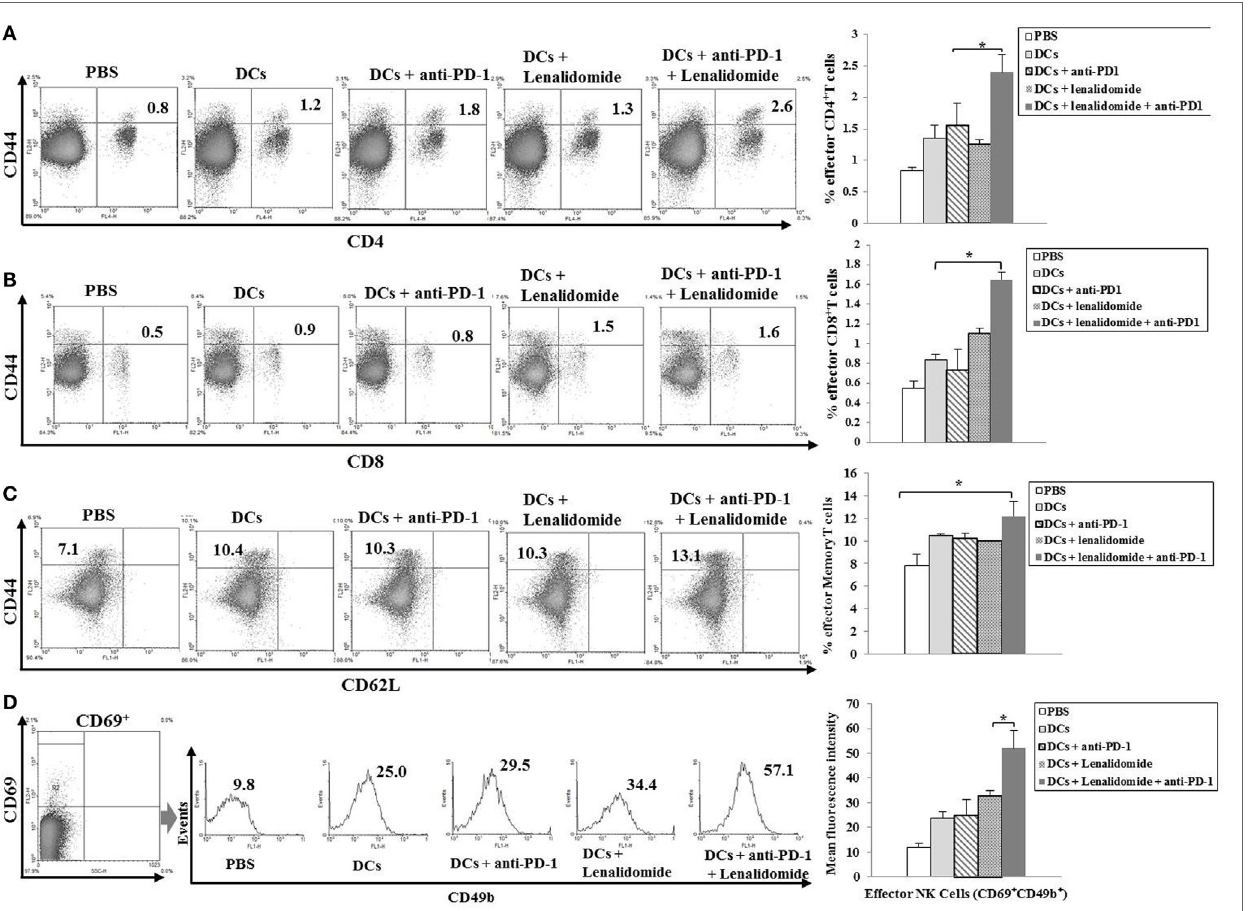
FigUre 3 | Induction of CD4 + T cells, CD8 + T cells, memory T cells, and natural killer (NK) cells in the spleens of mice treated with a combination of dendritic cells (DCs) plus lenalidomide and anti-PD-1. We measured proportions of (a) CD4 + T cells, (B) CD8 + T cells, (c) memory T cells, and (D) NK cells using flow cytometry (left panel) and compared them using quantitative bar graphs (right panel). The results revealed significant increases in effector cells in the DCs plus lenalidomide and anti-PD-1 combination group compared to the other groups (* P < 0.05). Data are representative of three independent